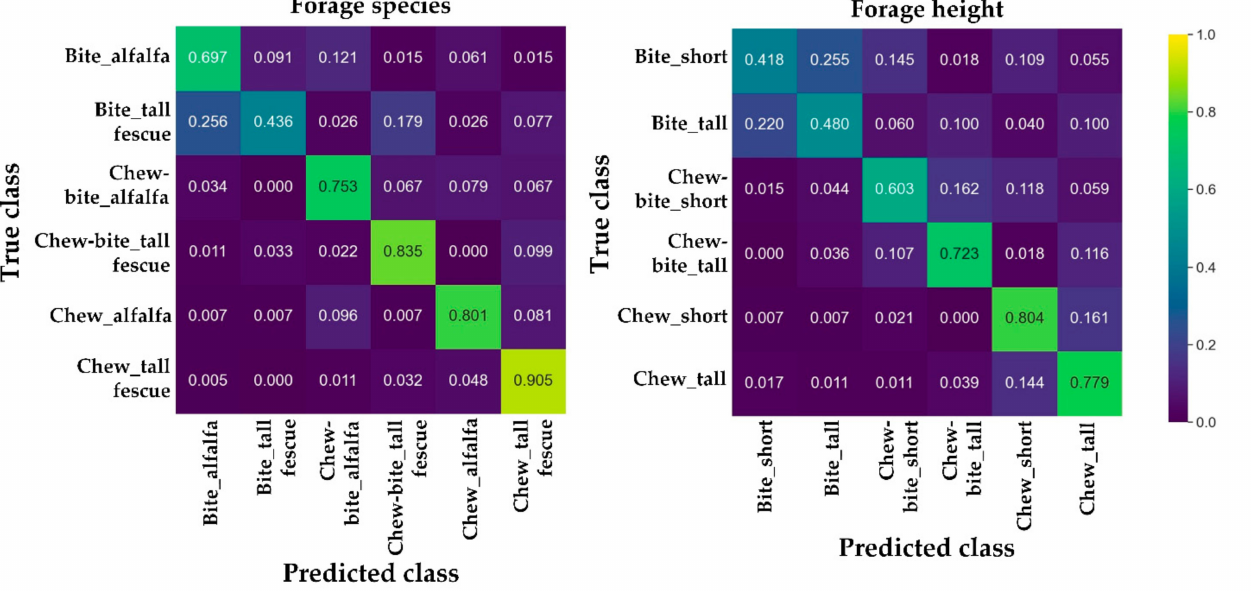
Figure 9. Confusion matrixes for classifying the ingestive behaviors under various forage characteristics. The model performance was investigated with the long short-term memory model and the filtered and imbalanced